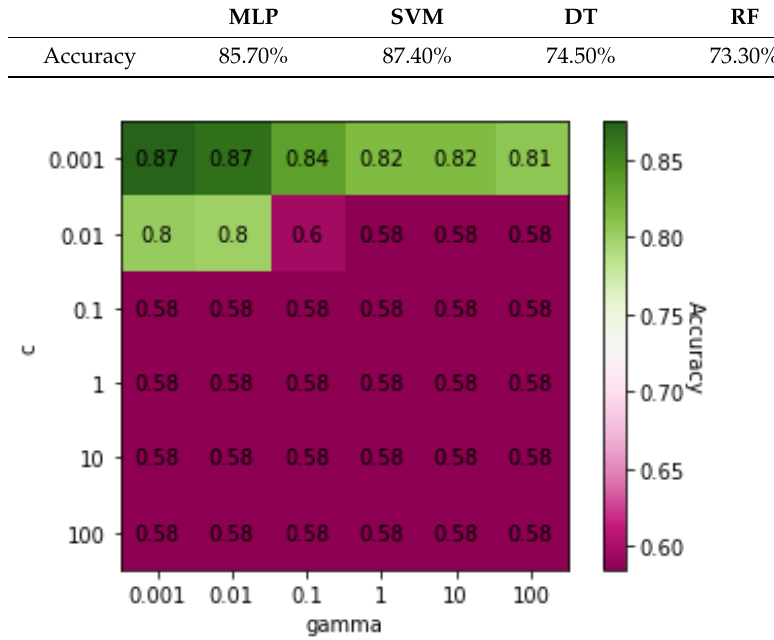
Table 4. Classification results for Dataset 01 (COPD/ILD).